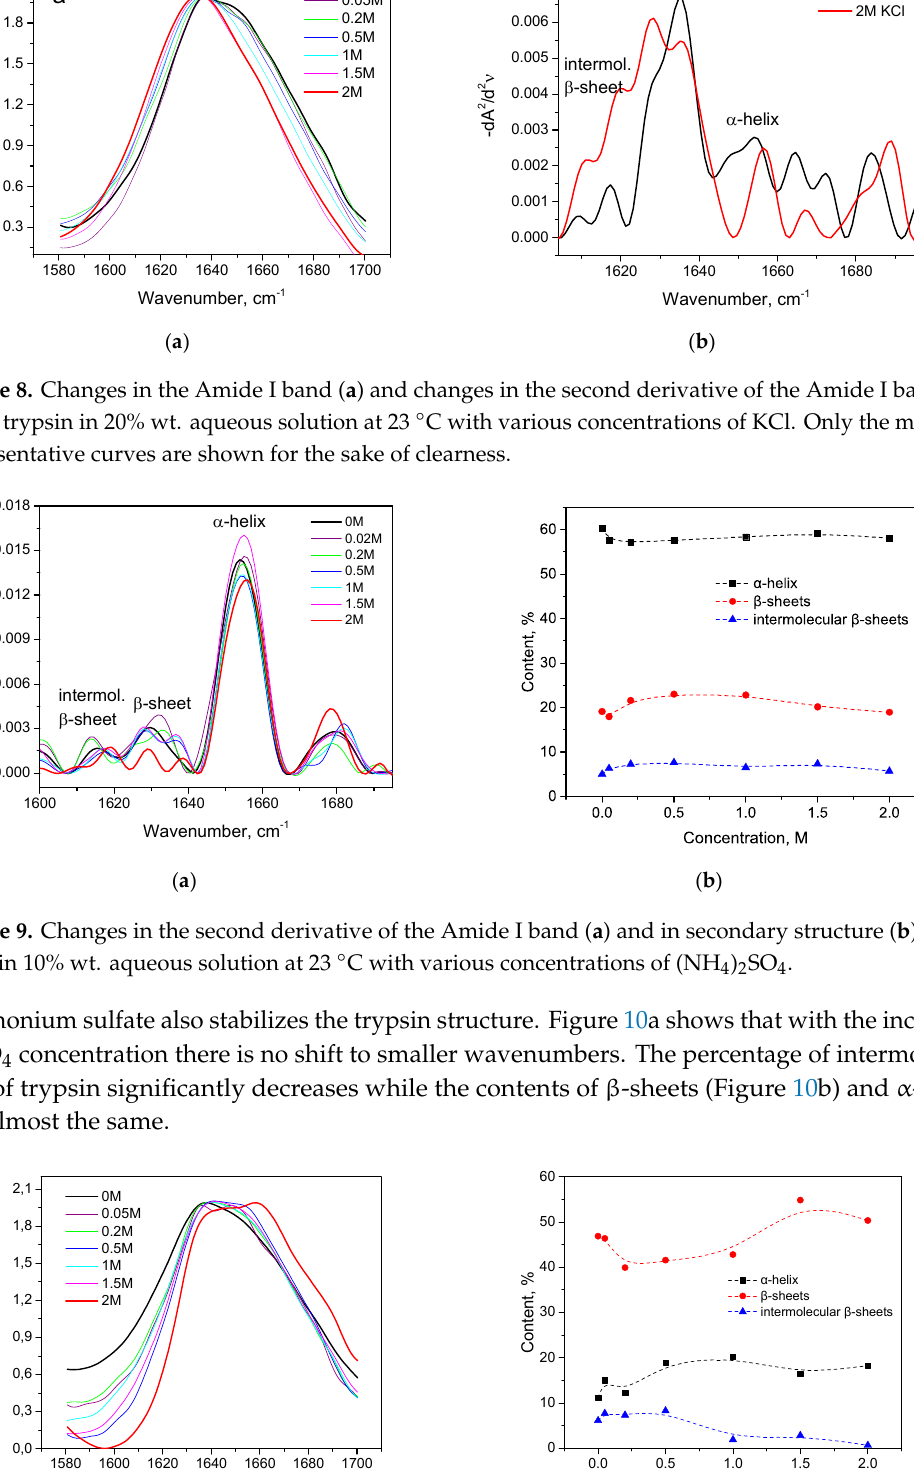
( b ) Figure 11. Changes in the character of the Amide I band ( a ) and changes in the second derivative of the Amide I band ( b ) of HSA in 10% wt. aqueous solution at 80 °C with various concentrations of KSCN. Only the most representative curves are shown for the sake of clearness.